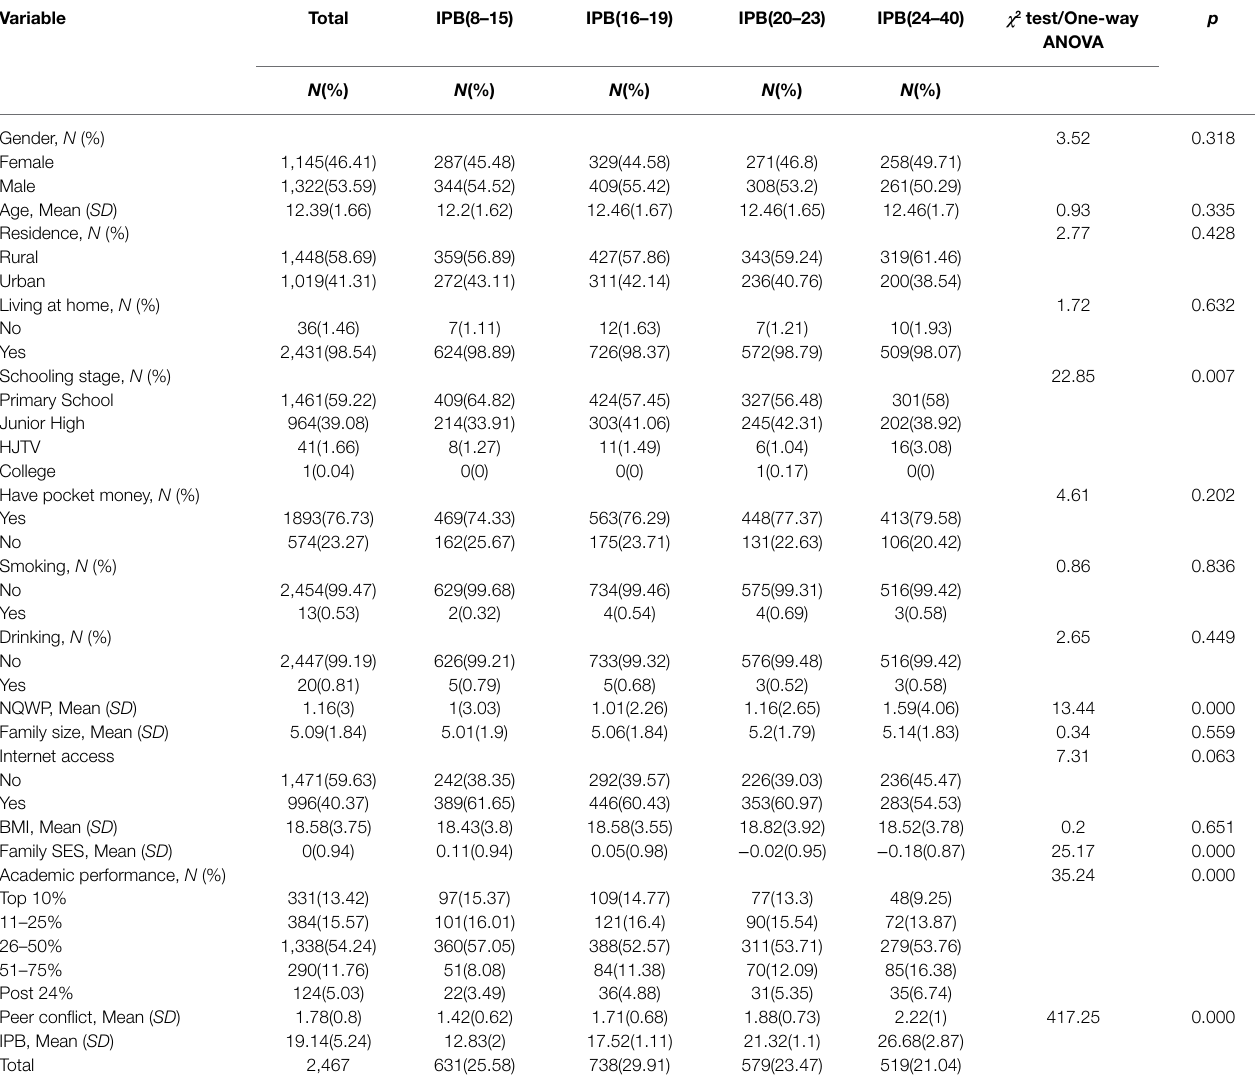
TABLE 1 | Characteristics of study participants and internalizing problem behavior score distribution ( n = 2,467).